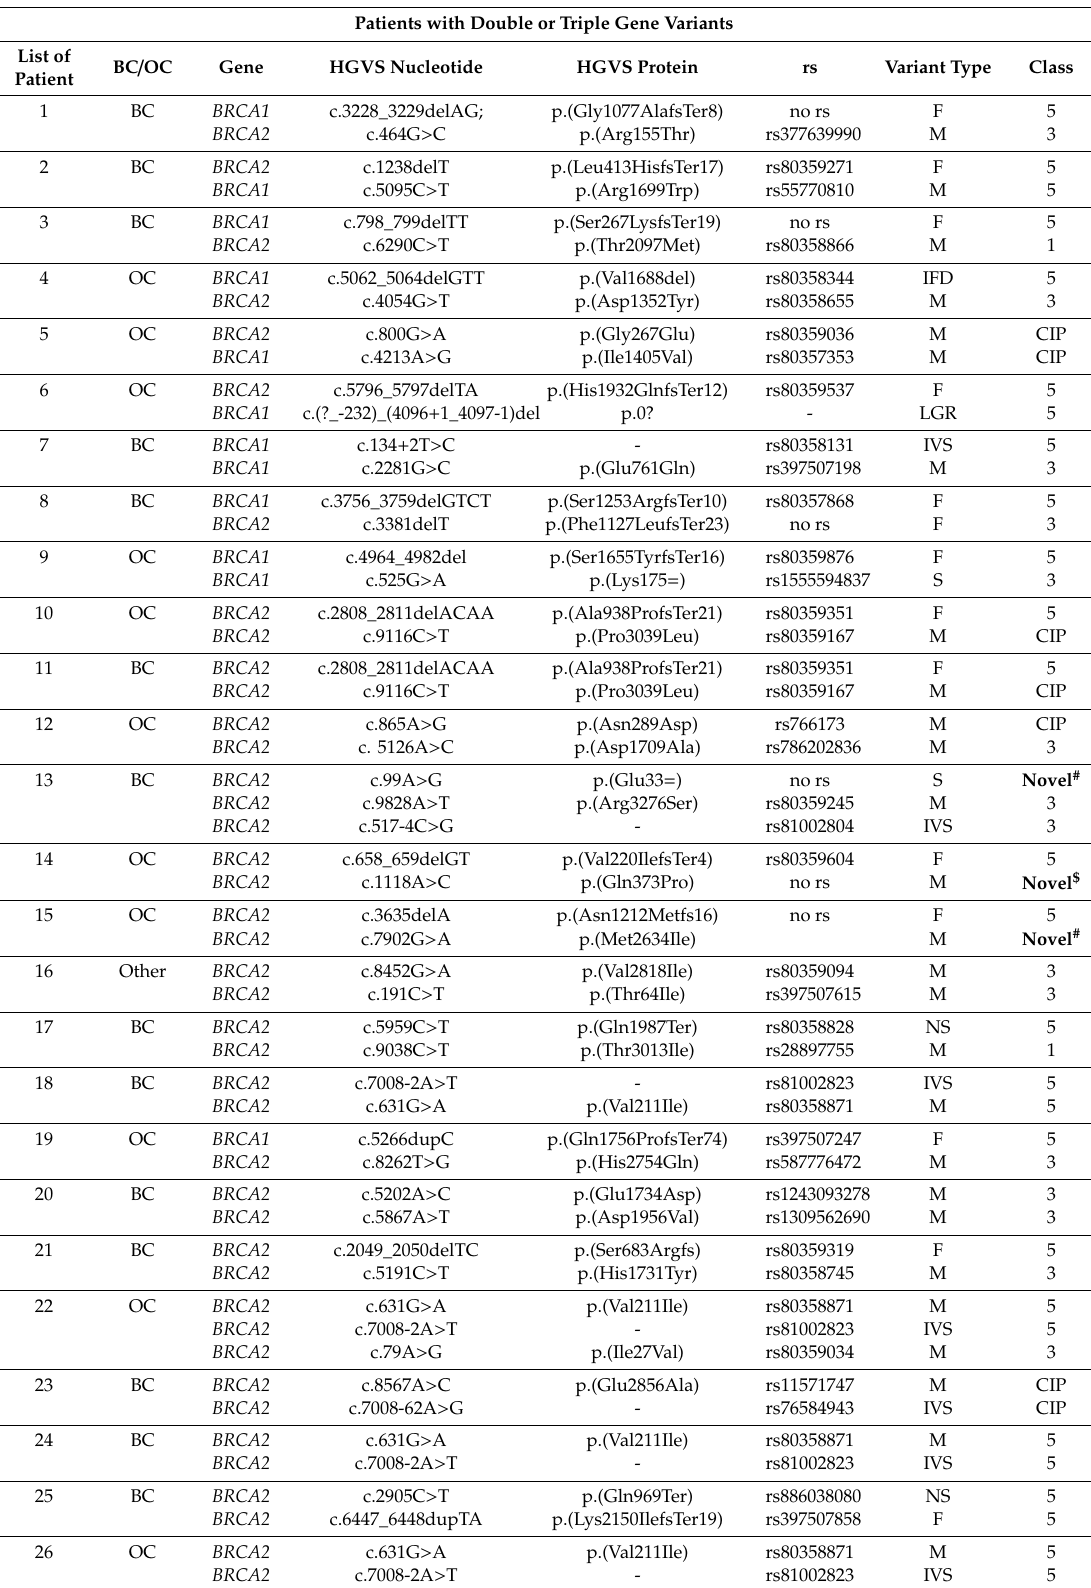
Table 3. Combination of Class 5, Class 4, and Class 3 variants in the BRCA1 and BRCA2 genes within each patient. Patients with Double or Triple Gene